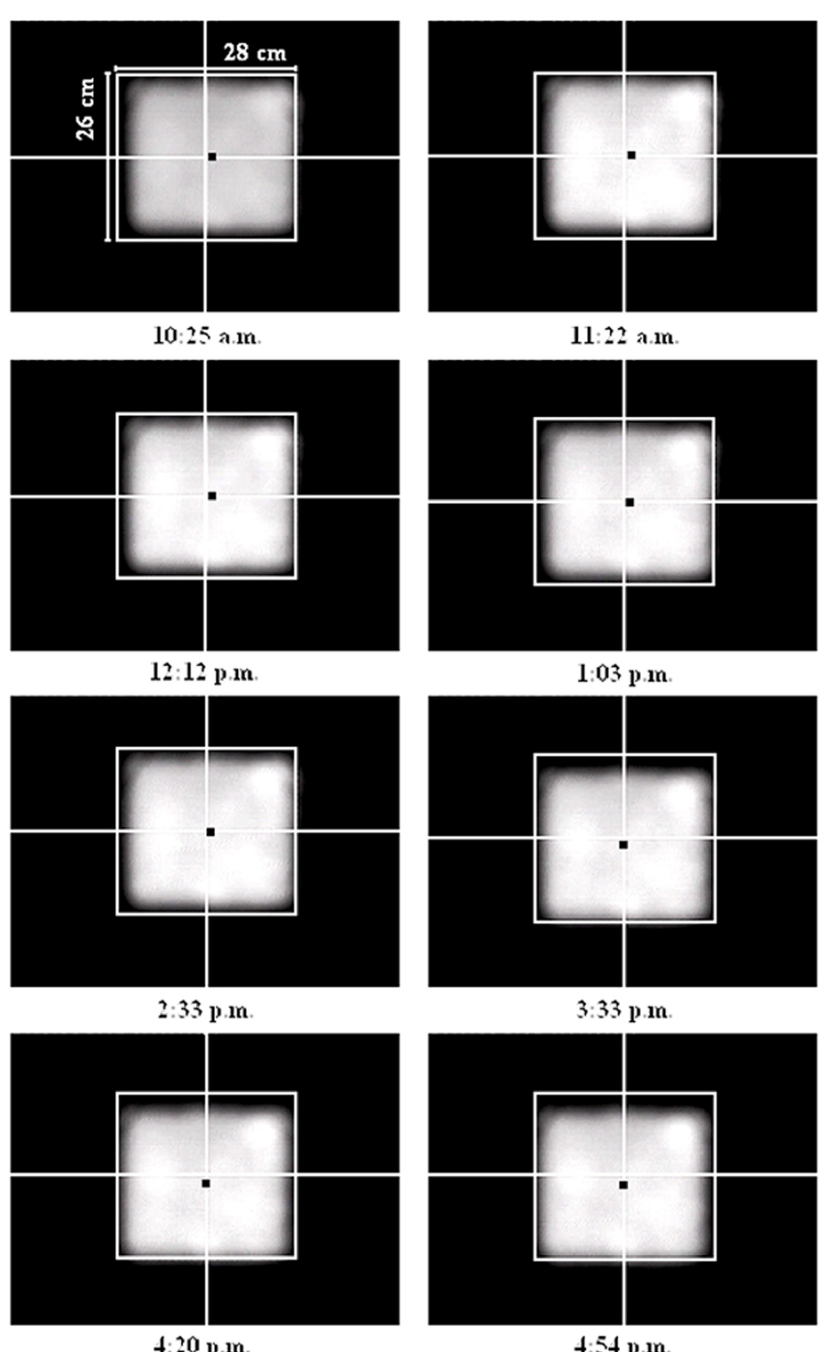
Figure 8. The recorded solar images on the target of prototype solar concentrator using a CCD camera from 10:25 am. to 4:54 pm. on 16 January 2009 with φ = − 0.1°; λ = 0°; and ζ = −